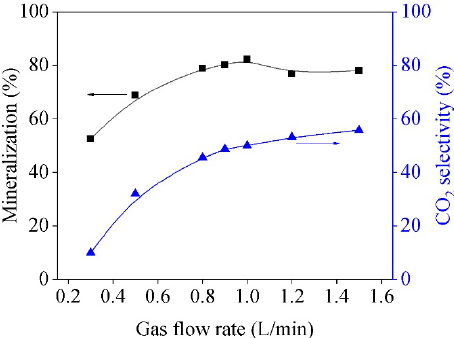
Figure 6. Effect of the total gas flow rate on the mineralization and CO 2 selectivity in a DBD reactor filled with Al 2 O 3 . (Discharge power: 55 W; driving frequency: 12.6 kHz; naphthalene carrying gas: 200 mL/min; discharge gap: 3 mm).